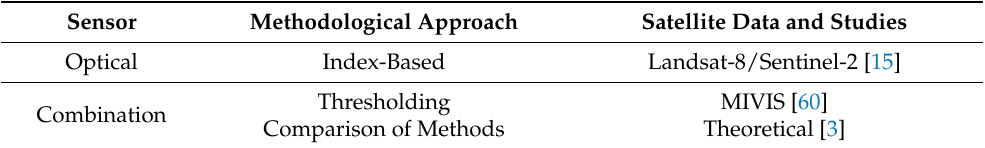
Table 3. Overview of the related work concerning combined fire and burned area detection. The following abbreviation is used: MIVIS—Multispectral Infrared and Visible Imaging